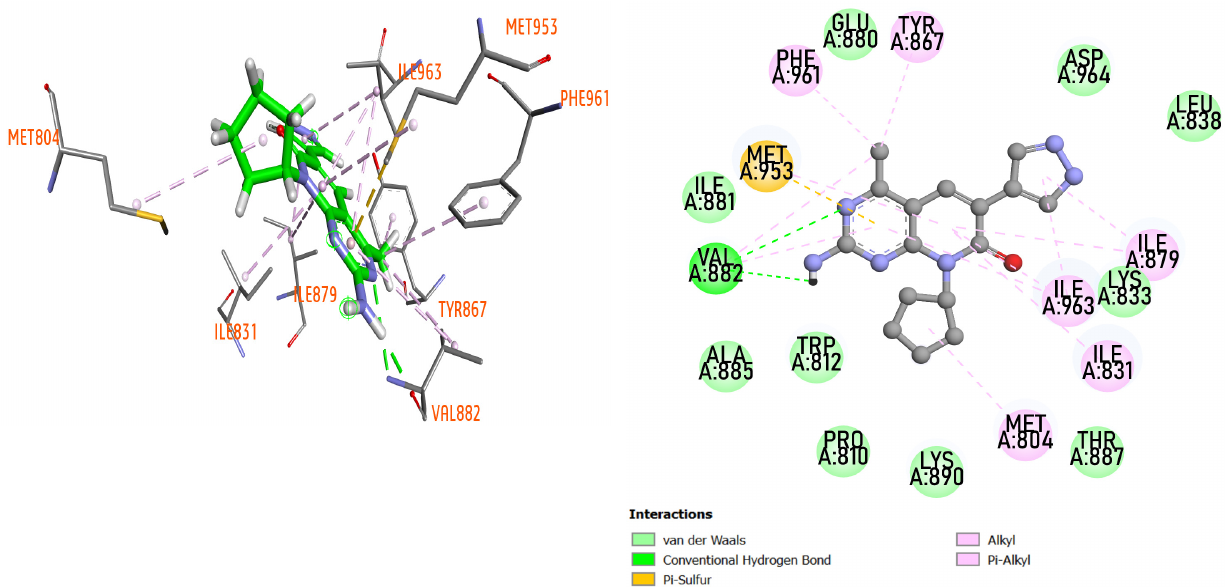
Figure 2. The 3D and 2D representations of the interactions of the studied compound inside the active sites of the PI3K α /mTOR target protein.